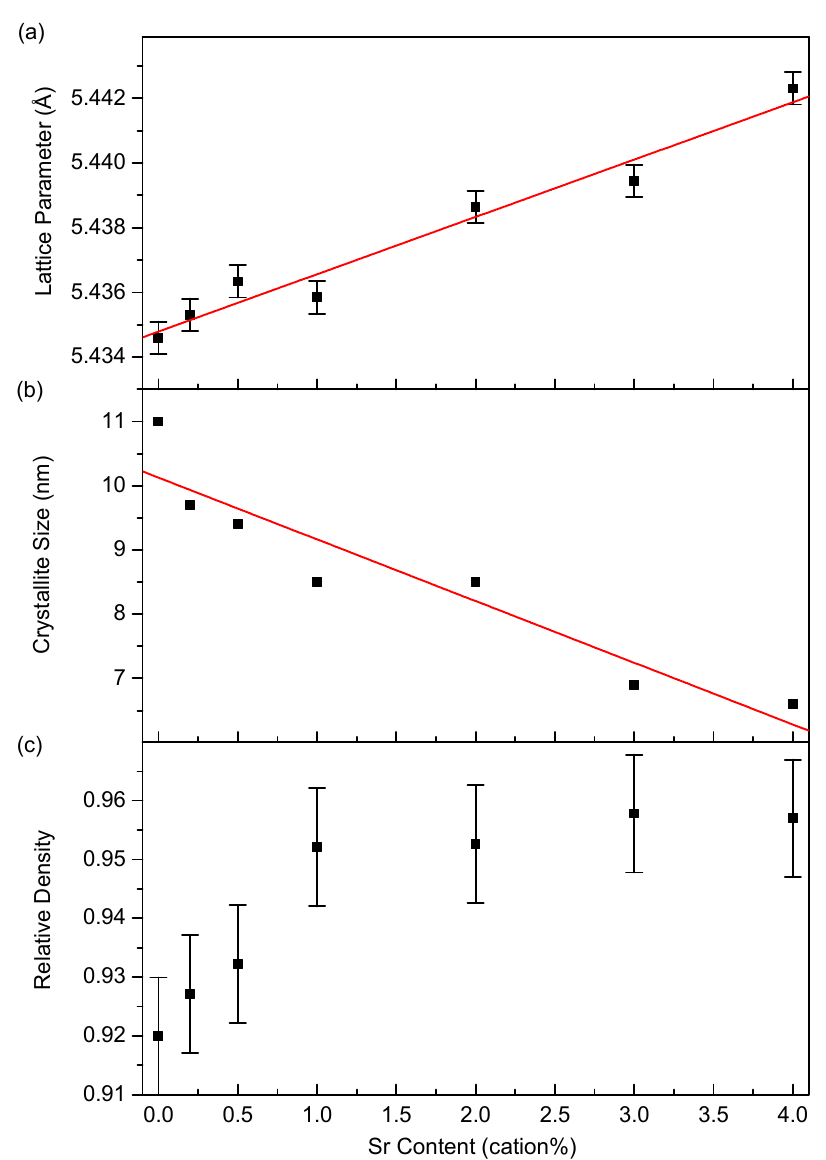
Figure 1. Plots against Sr content (x) of ( a ) lattice parameter, ( b ) average crystallite size, as calculated by the Scherrer equation, and ( c ) relative density of the Ce 0.8-x Sm 0.2 Sr x O 2- δ powders after sintering at 1450 °C for 4 h.